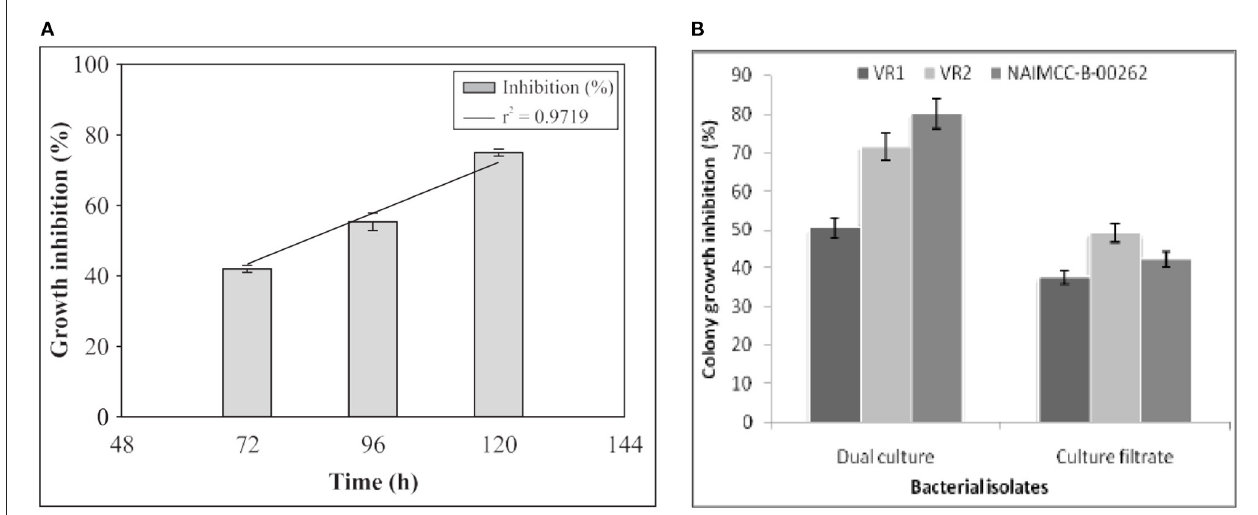
FIGURE 3 | (A) The inhibition of growth of Sclerotinia sclerotiorum by Mesorhizobium loti MP6 in vitro at different days of incubation (Chandra et al., 2007). (B) The inhibition of growth of Macrophomina phaseolina in vitro by Bradyrhizobium isolates in dual culture and by cell-free extract at 28 ± 1 ◦ C ( Dubey et al.,